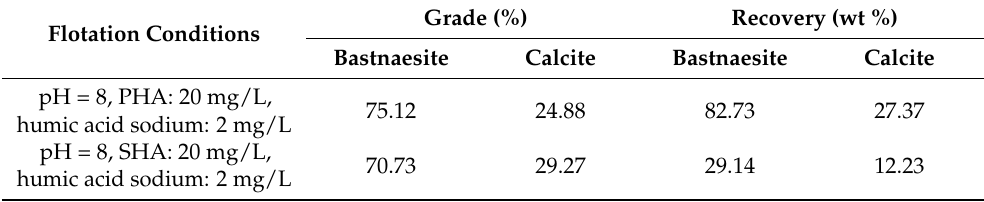
Table 2. Flotation separation of artificial mixed minerals results.